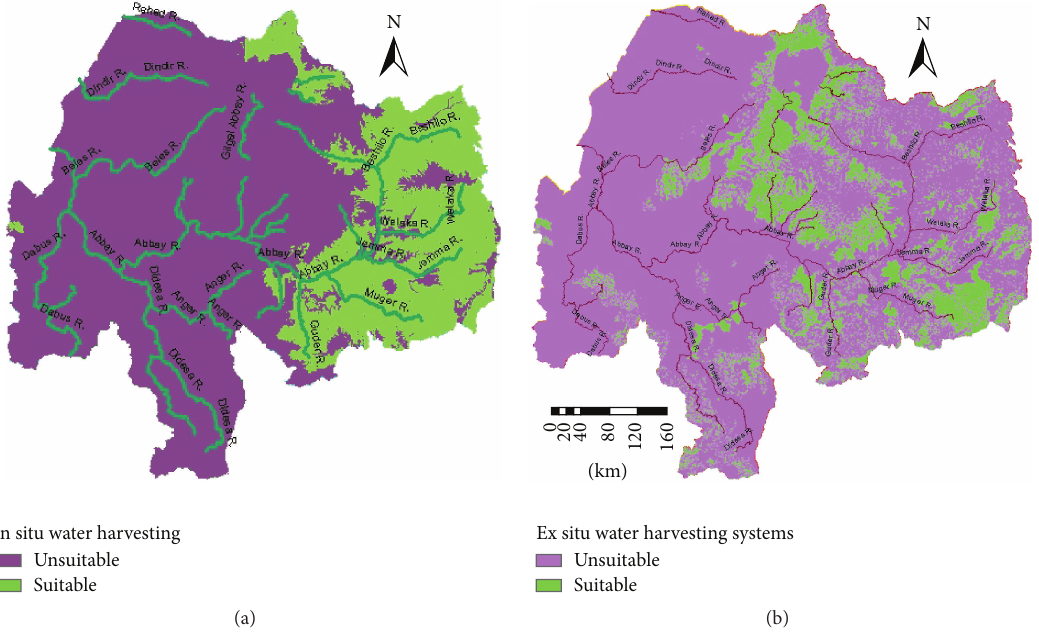
Figure 3: Suitability analysis for (a) in situ water harvesting practices and (b) ex situ water harvesting practices in the Upper Blue Nile Basin using a Boolean MCE technique.